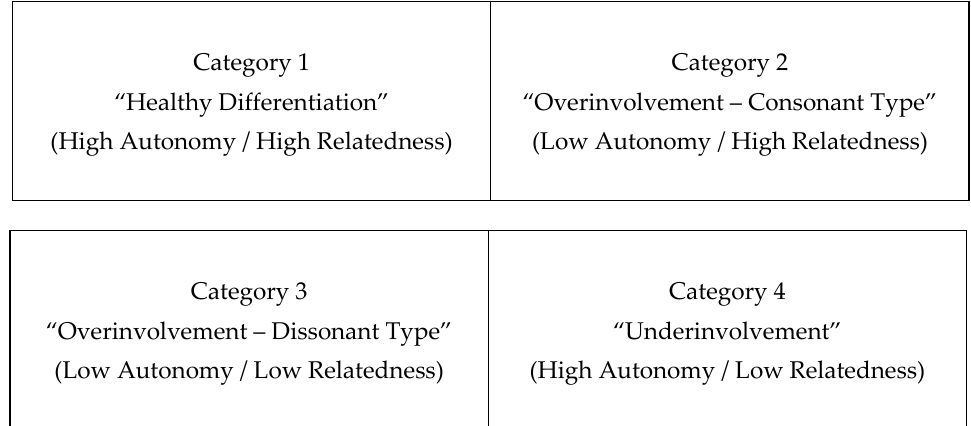
Figure 2. Stutman and Lich (1984) Family Differentiation Categorization System.